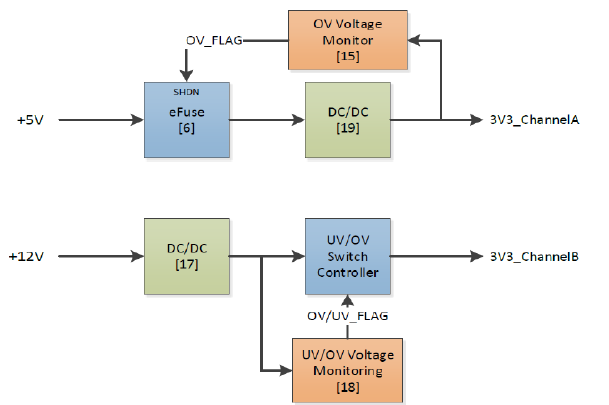
Figure 8. Block diagram of Safe power